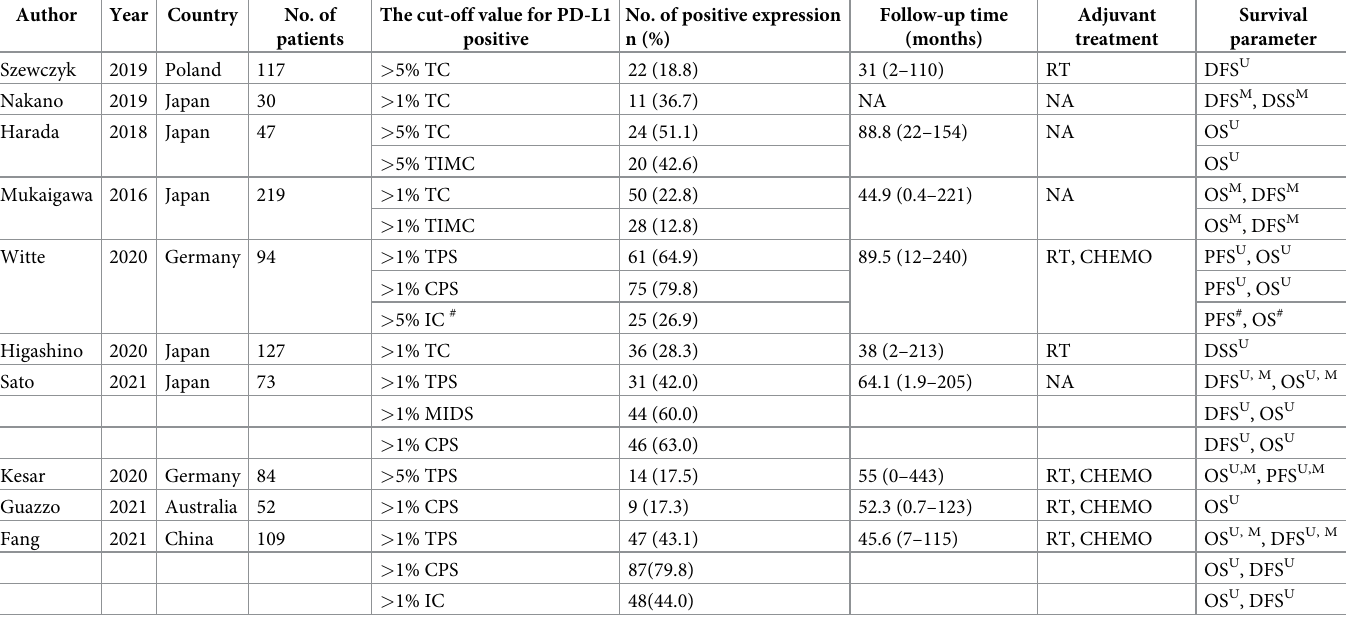
Table 1. Summary of the studies that examined the prognostic value of PD-L1 in